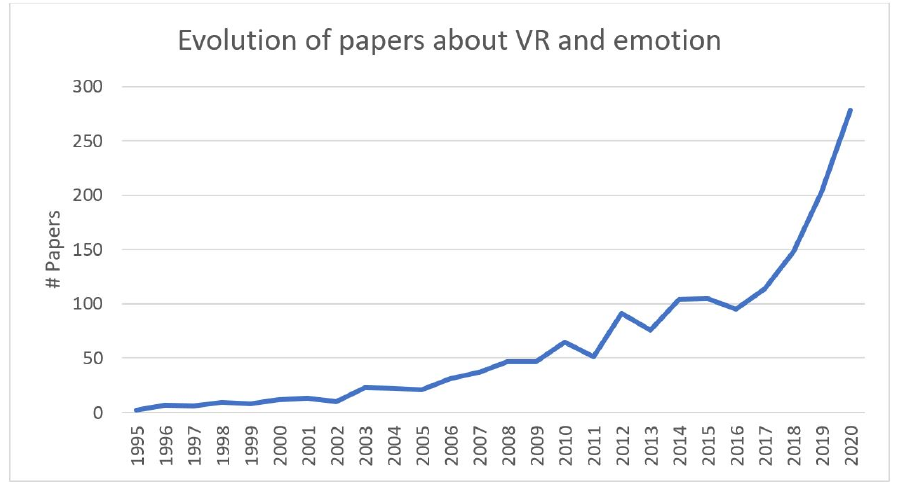
Figure 2. Evolution of the number of papers published each year on the topic of virtual reality and emotions. The total number of papers to be published in 2020 has been extrapolated using data up to